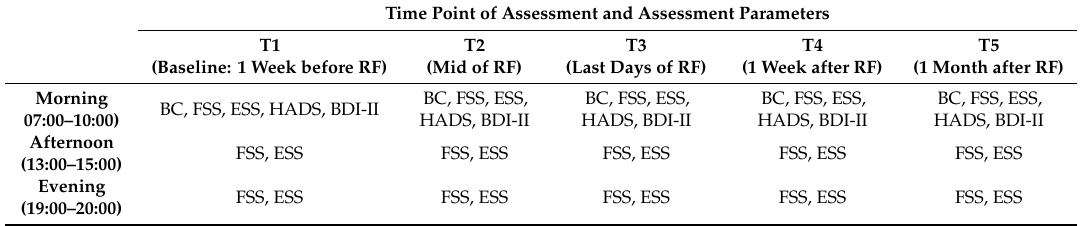
Table 1. Study design of RF. Time Point of Assessment and Assessment